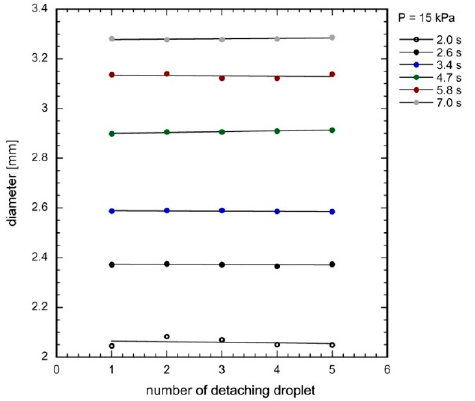
Figure 5. Diameter of single, subsequent droplets generated with constant overpressure but different opening times of the servo-valve of the oil cell (Cell 2).